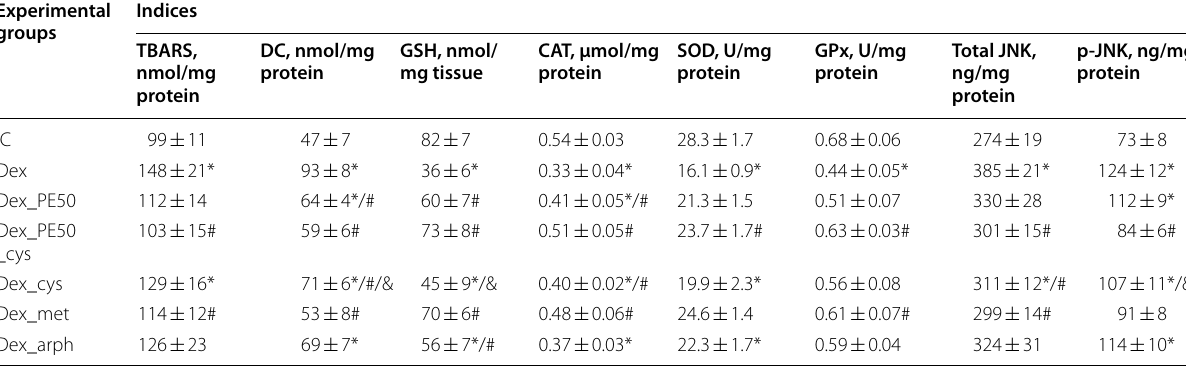
Each value represents the mean * Indicates significant difference relative to IC group (p # Indicates significant difference relative to Dex group (p & Indicates significant difference relative to Dex_PE_cys group (p